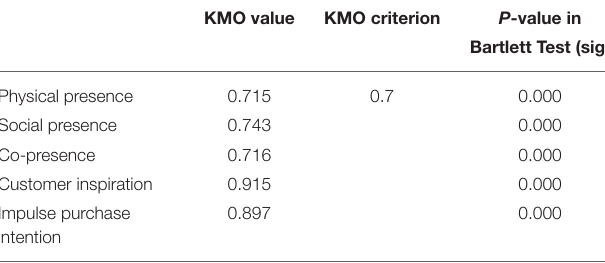
TABLE 3 | Results of reliability analysis. TABLE 4 | Results of KMO measure and bartlett test of